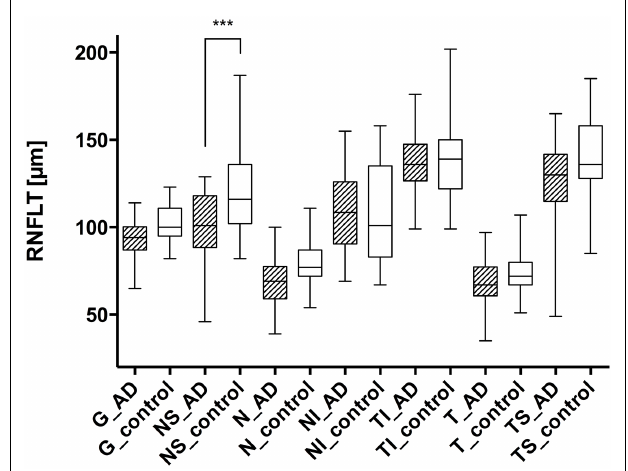
FIGURE 1 | Comparison of the retinal nerve fiber layer thickness in different peripapillary sectors: each left column represents the patient withAD (AD), while the right columns show the values of the control group (control) .The different sectors are labeled as follows: global (G), nasal superior (NS), nasal (N), nasal inferior (NI), temporal inferior (TI), temporal (T), and temporal superior (TS). Significant differences (with Bonferroni correction) were only registered in the nasal superior sector ( P < 0.0001), indicated as